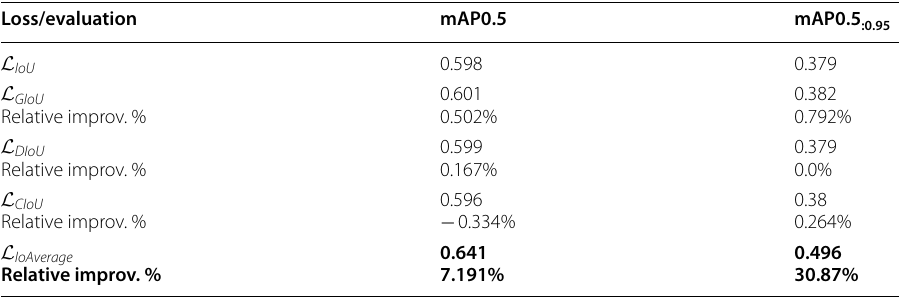
Table 4 Comparison between the performance of yolov5s trained using its own loss ( L IoU ) as well as L GIoU , L DIoU , L CIoU and proposed scheme L IoAverage losses. The results are reported on the test dataset of pascal voc 2007 mAP0.5 mAP0.5